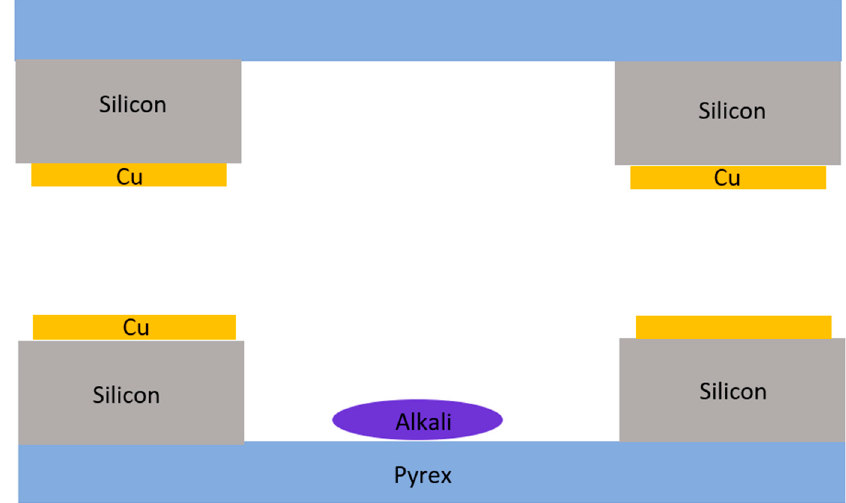
Figure 5. Cu-Cu-bonded alkali metal vapor cell.